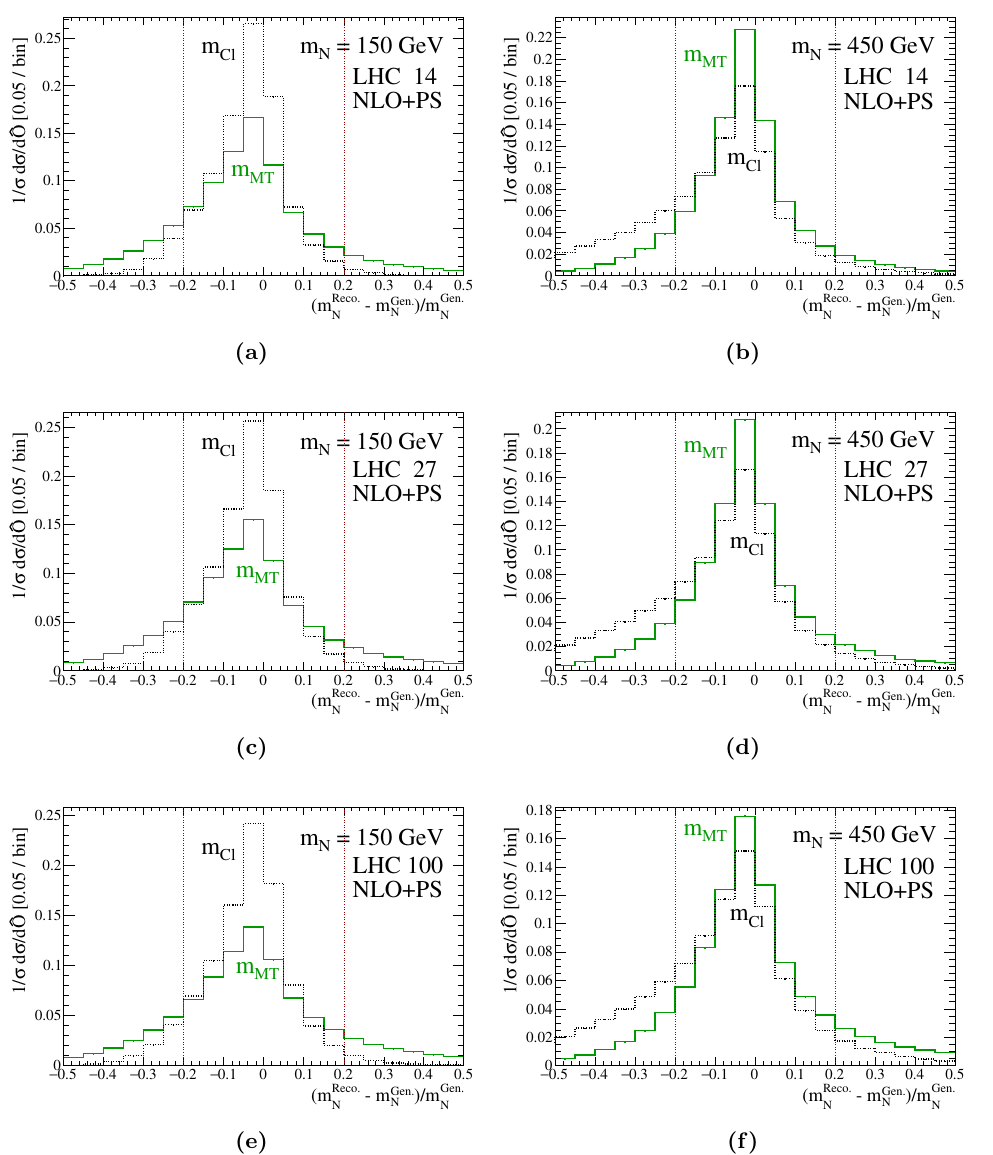
Figure 13. The relative di(cid:11)erence ( (cid:14)m=m ) between the value of the reconstructed mass m Reco : ^ m MT (solid) ; ^ m Cl (dot) and m Gen : m for (a,c,e) m N = 150 GeV and (b,d,f) 450 GeV, at (a,b) N f g p s = 14, (c,d) 27, and (e,f) 100 TeV, and at NLO+PS. Guide lines placed at